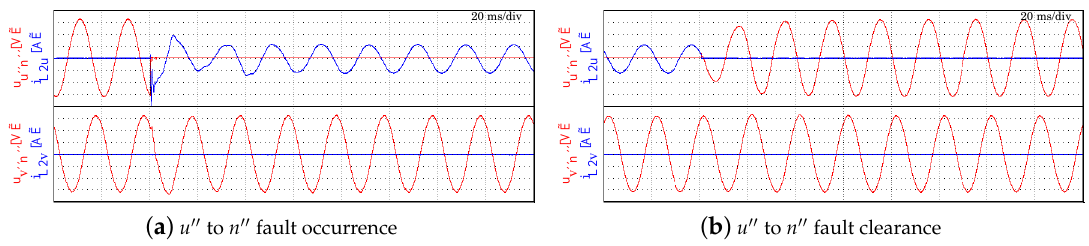
Figure 18. Scenario 1 (phase to neutral short-circuit fault). u x (cid:48)(cid:48) n (cid:48)(cid:48) (100 V/div) and i L 2 x (150 A/div).